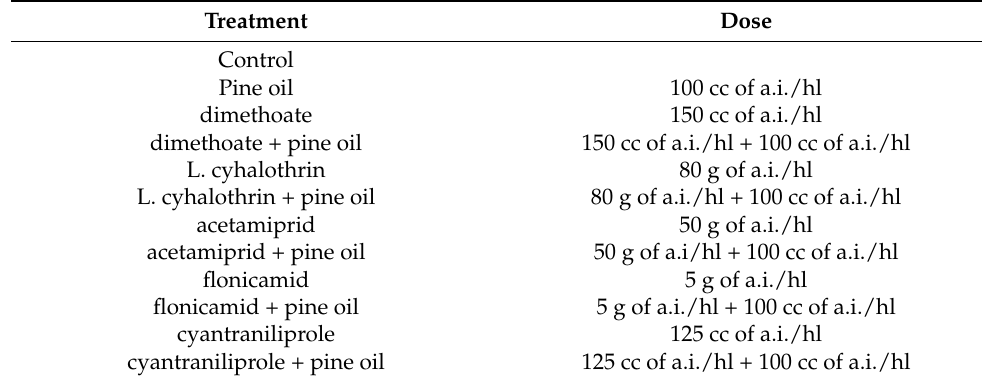
Table 2. Treatments applied in semi-field and field